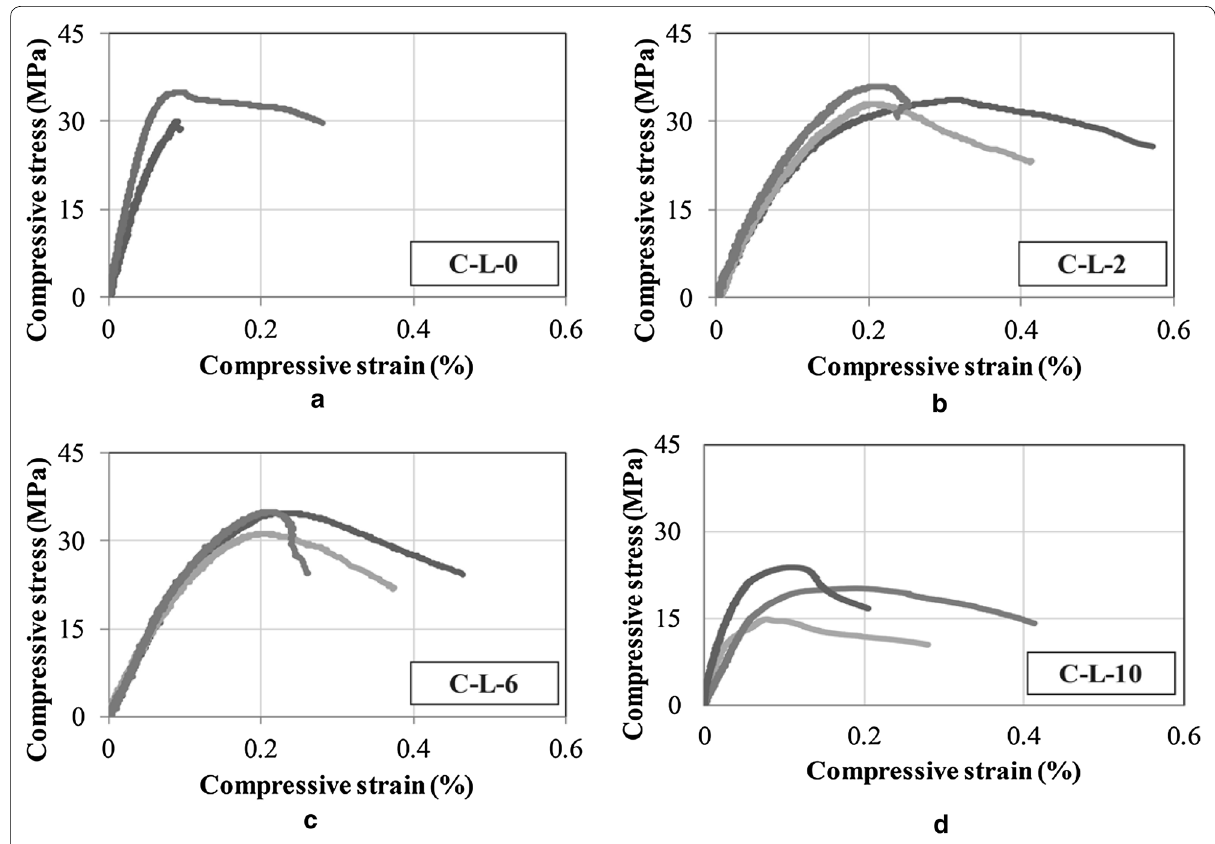
Fig. 15 Compressive stress–strain curves with L-level aggregates: a C-L-0, b C-L-2, c C-L-6, and d C-L-10.